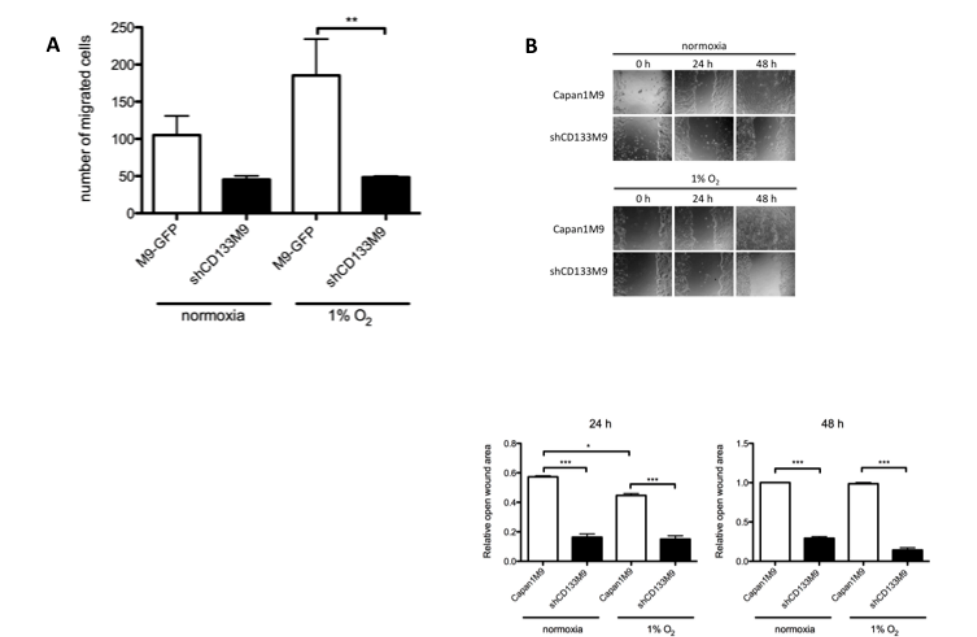
Figure 3. CD133 plays an important role in pancreatic cancer cell migration under hypoxia. ( A ) Boyden chamber migration assay showed CD133 silencing reduced the migratory ability of Capan1M9 both in normoxia and hypoxia. Capan1M9 only enhanced its migration ability under hypoxia; ( B ) Wound healing assay also showed CD133 silencing reduced the migratory ability of Capan1M9 in normoxia and hypoxia. Hypoxia discouraged wound healing of Capan1M9 and shCD133M9. Wide error bars for Capan1M9 cell migrations are due to varying cell number between experiments. Data represent mean ± SD of three experiments; * p < 0.05; ** p < 0.01; *** p < 0.001.